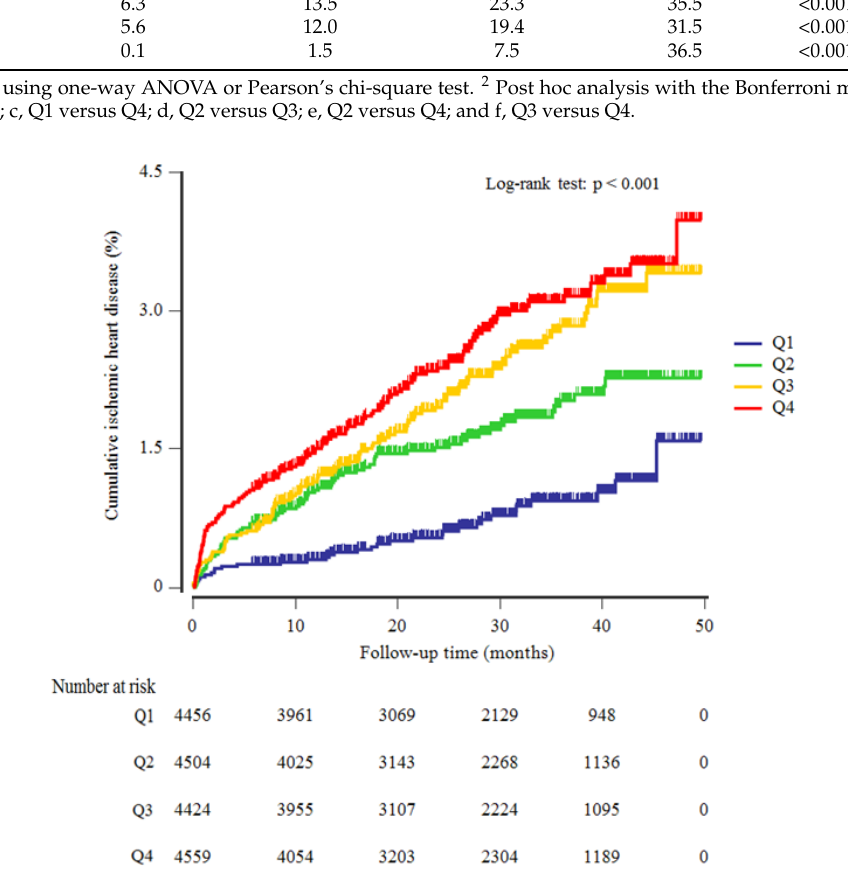
Figure 2. Kaplan–Meier plots indicating the cumulative ischemic heart disease. Table 2 shows the results of the multivariate Cox proportional hazards regression analysis for the prediction of IHD according to the METS-IR index quartile. A total of 332 individuals (1.9%, 332/17,943) developed IHD during the study period. The incidence rate (per 1000 person-years) of IHD increased proportionally as the METS-IR index quartile increased. Compared with the first METS-IR index quartile, the HRs of incident IHD for the second, third, and fourth quartiles increased in a dose-dependent manner. The HRs of incident IHD were 1.62 (95% CI 1.04–2.53), 1.87 (95% CI 1.20–2.91), and 2.11 (95% CI 1.35– 3.30) for the second, third, and fourth METS-IR index quartiles, respectively, after adjust- ing for age, sex, smoking status, alcohol intake, physical activity, mean arterial blood pres- sure, total cholesterol, hsCRP, eGFR, and hypertension medication. Table 2. Hazard ratios and 95% CIx for new-onset IHD according to METS-IR quartiles. METS-IR Quartiles Q1